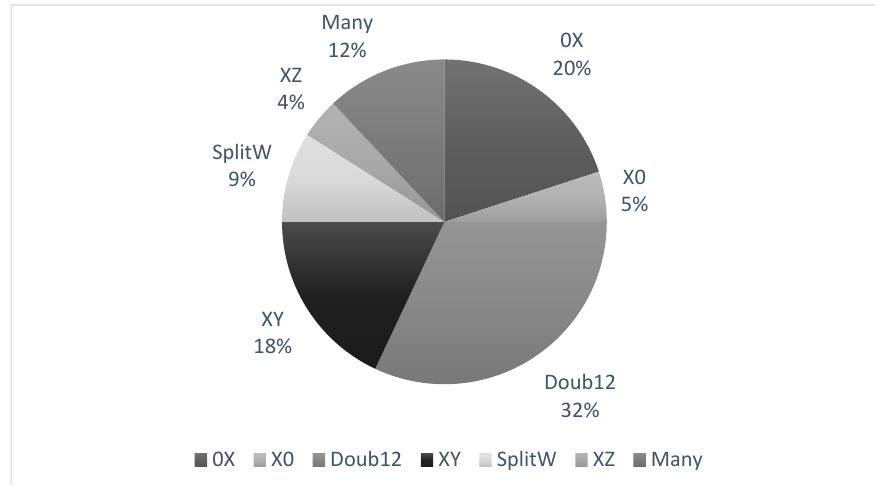
Figure 1. Frequency of spelling error categories.